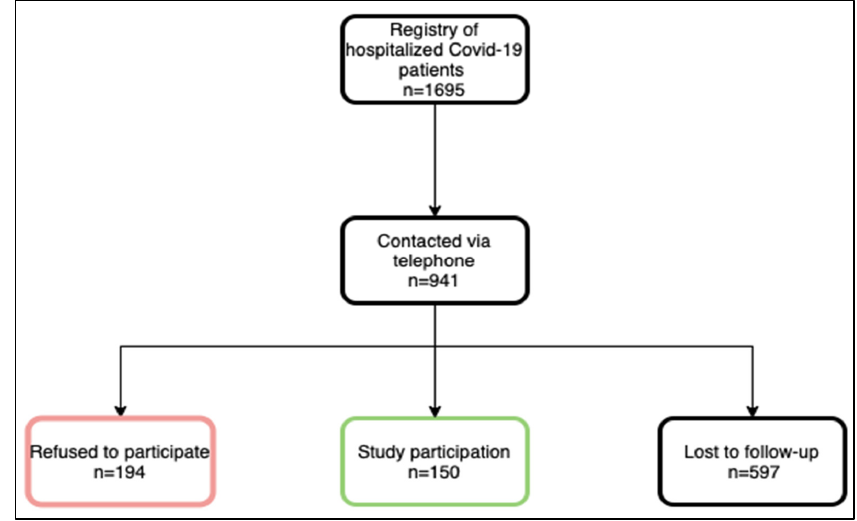
Figure 1. Description of the study enrollment process. n = number of patients.